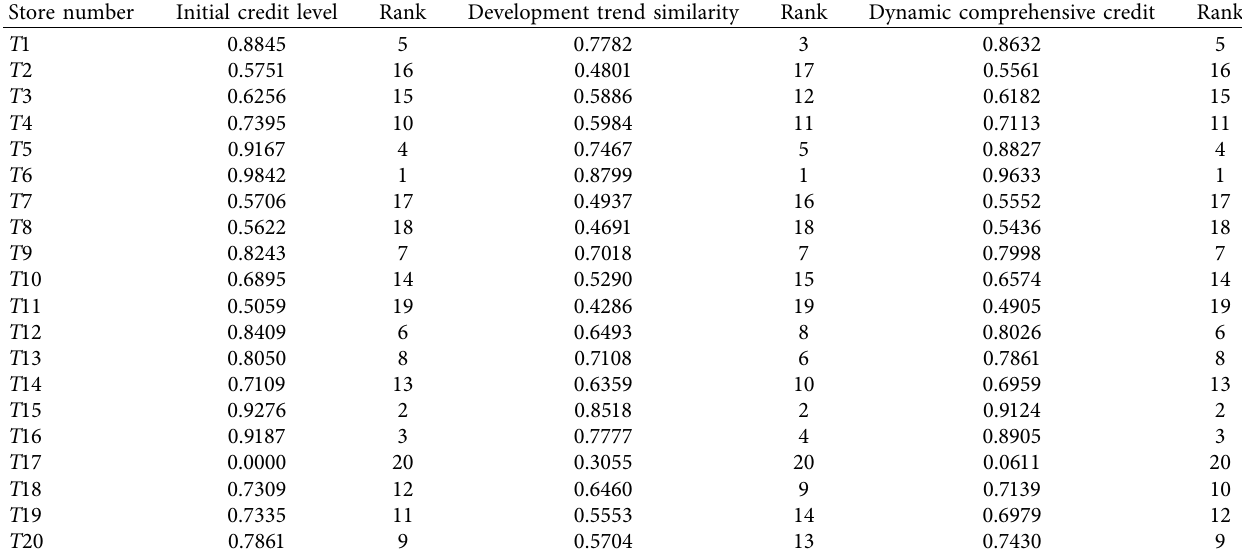
Table 3: Dynamic evaluation